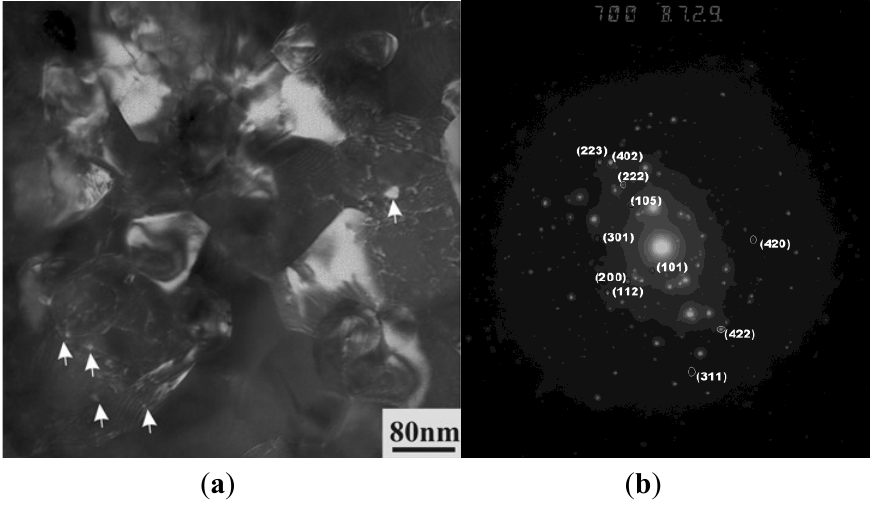
Figure 3. ( a ) TEM micrographs coarse grains; ( b ) ultrafine grains in the center of the sample.